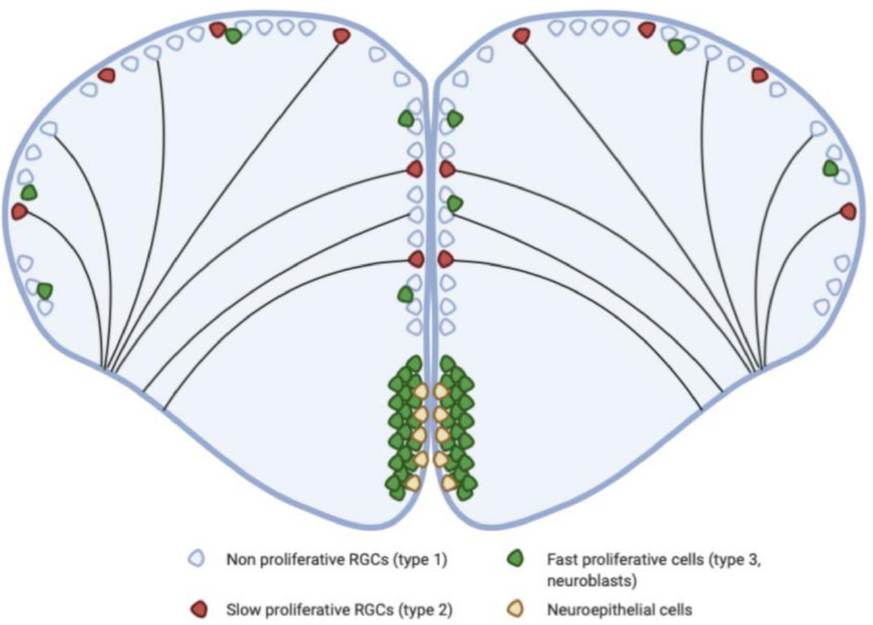
Figure 2. The telencephalon of adult zebrafish contains slow and fast cycling progenitors. The VZ of the dorsal telencephalon (pallium) is mainly composed of quiescent (type 1) or proliferative (type 2) RGCs corresponding to slow cycling progenitors. The ventral part of the telencephalon (subpallium) is composed of fast cycling progenitors (type 3 cells) identified as neuroblasts, grouped within a cluster and forming a rostral migratory like structure (RMS-like). Some neuroblasts are also observed scattered between RGC soma in the pallium. RGCs were identified as bona fide NSCs in the pallium and neuroepithelial cells could be NSCs in the subpallium. RGCs: radial glial